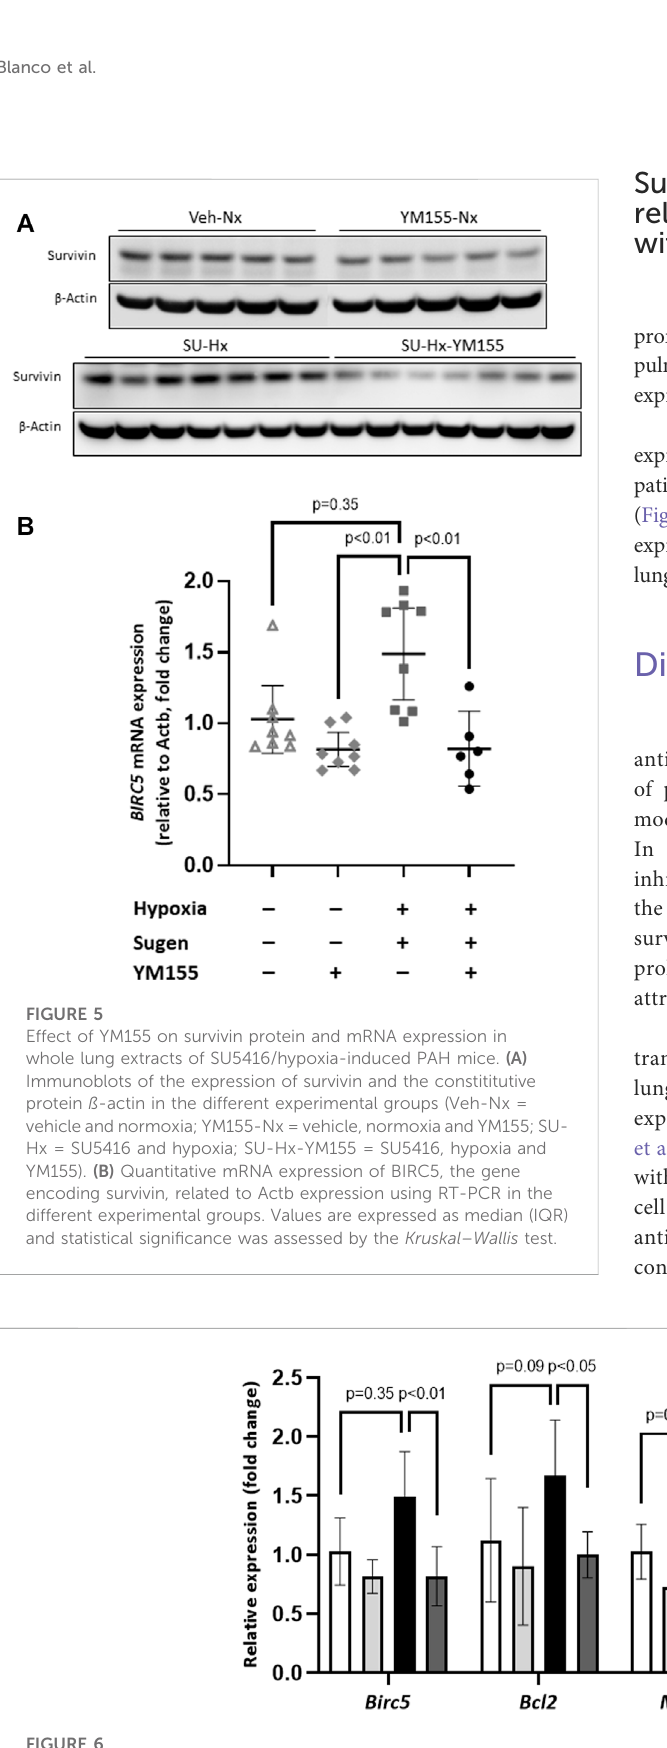
FIGURE 6 Effect of YM155 on apoptosis/proliferation related genes in whole lung extracts of SU5416/hypoxia-induced PAH mice. Quantitative mRNA expression of Birc5 , Bcl2 , and M ki 67 , related to Actb expression, using RT-PCR in the different experimental groups. Bcl2 and Mki67 values are expressed asmean±SDandstatisticalsigni fi cancewasassessedbytheone-wayANOVA.Birc5valuesareexpressedasmedian(IQR)andstatisticalsigni fi cancewas assessed by the Kruskal – Wallis